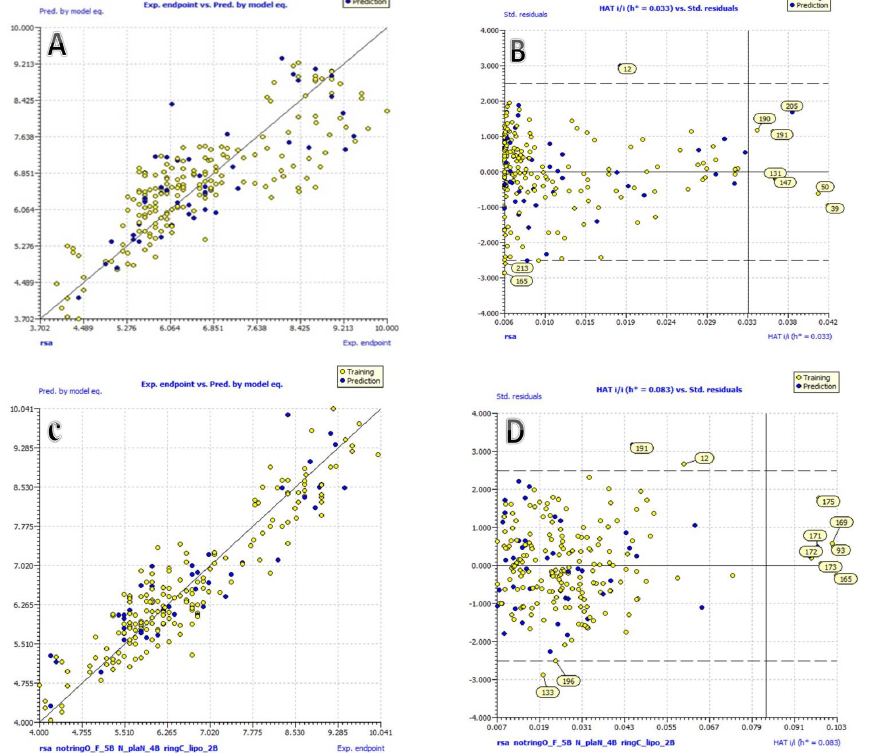
Figure 2. ( A ) Graph of experimental vs. Predicted pKi values for model 1.1; ( B ) Williams plot for model 1.1; ( C ) Graph of experimental vs. Predicted pKi values for model 1.2; ( D ) Williams plot for model 1.2.